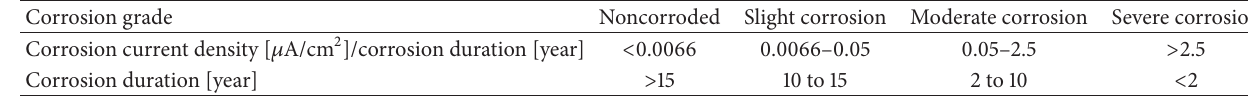
Table 5: Simple method to evaluate grade of